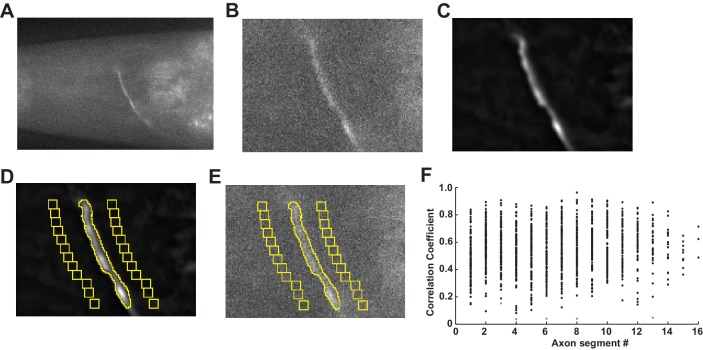
VGLUT-pH data acquisition.(A) Single plane of AWCON VGLUT-pH recording after drift-registration correction. (B) Zoomed view around the axon in (A). (C) Mean intensity projection after the recording was processed by rolling background subtraction and 3D-averaging. (D) Selection of axon and background ROIs. (E) Intensity measurements are then taken from the raw drift-corrected recording. (F) ROI segments along the axon correlated with overall mean activity of the axon. Each point represents the correlation coefficient of an axon segment with the mean signal of the axon during a standard recording (see Materials and methods). Data from 120 AWCON VGLUT-pH axons stimulated with 11.2 µM butanone. Each axon had 8–16 ROI segments. p<0.000001 for all correlation coefficients except the points labeled in light gray, which were not significant p>0.05.